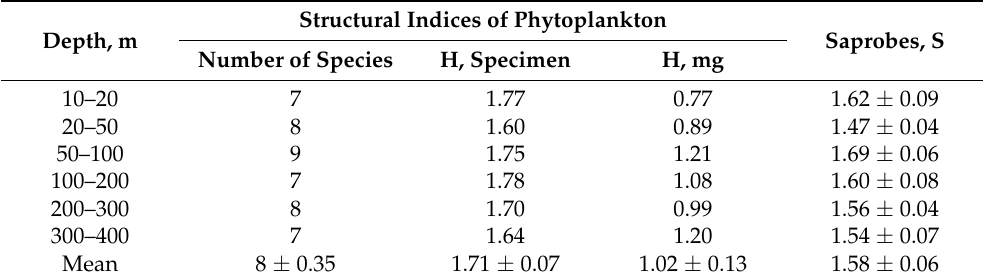
Table 4. Variety of phytoplankton according to the Shannon–Weaver index and water